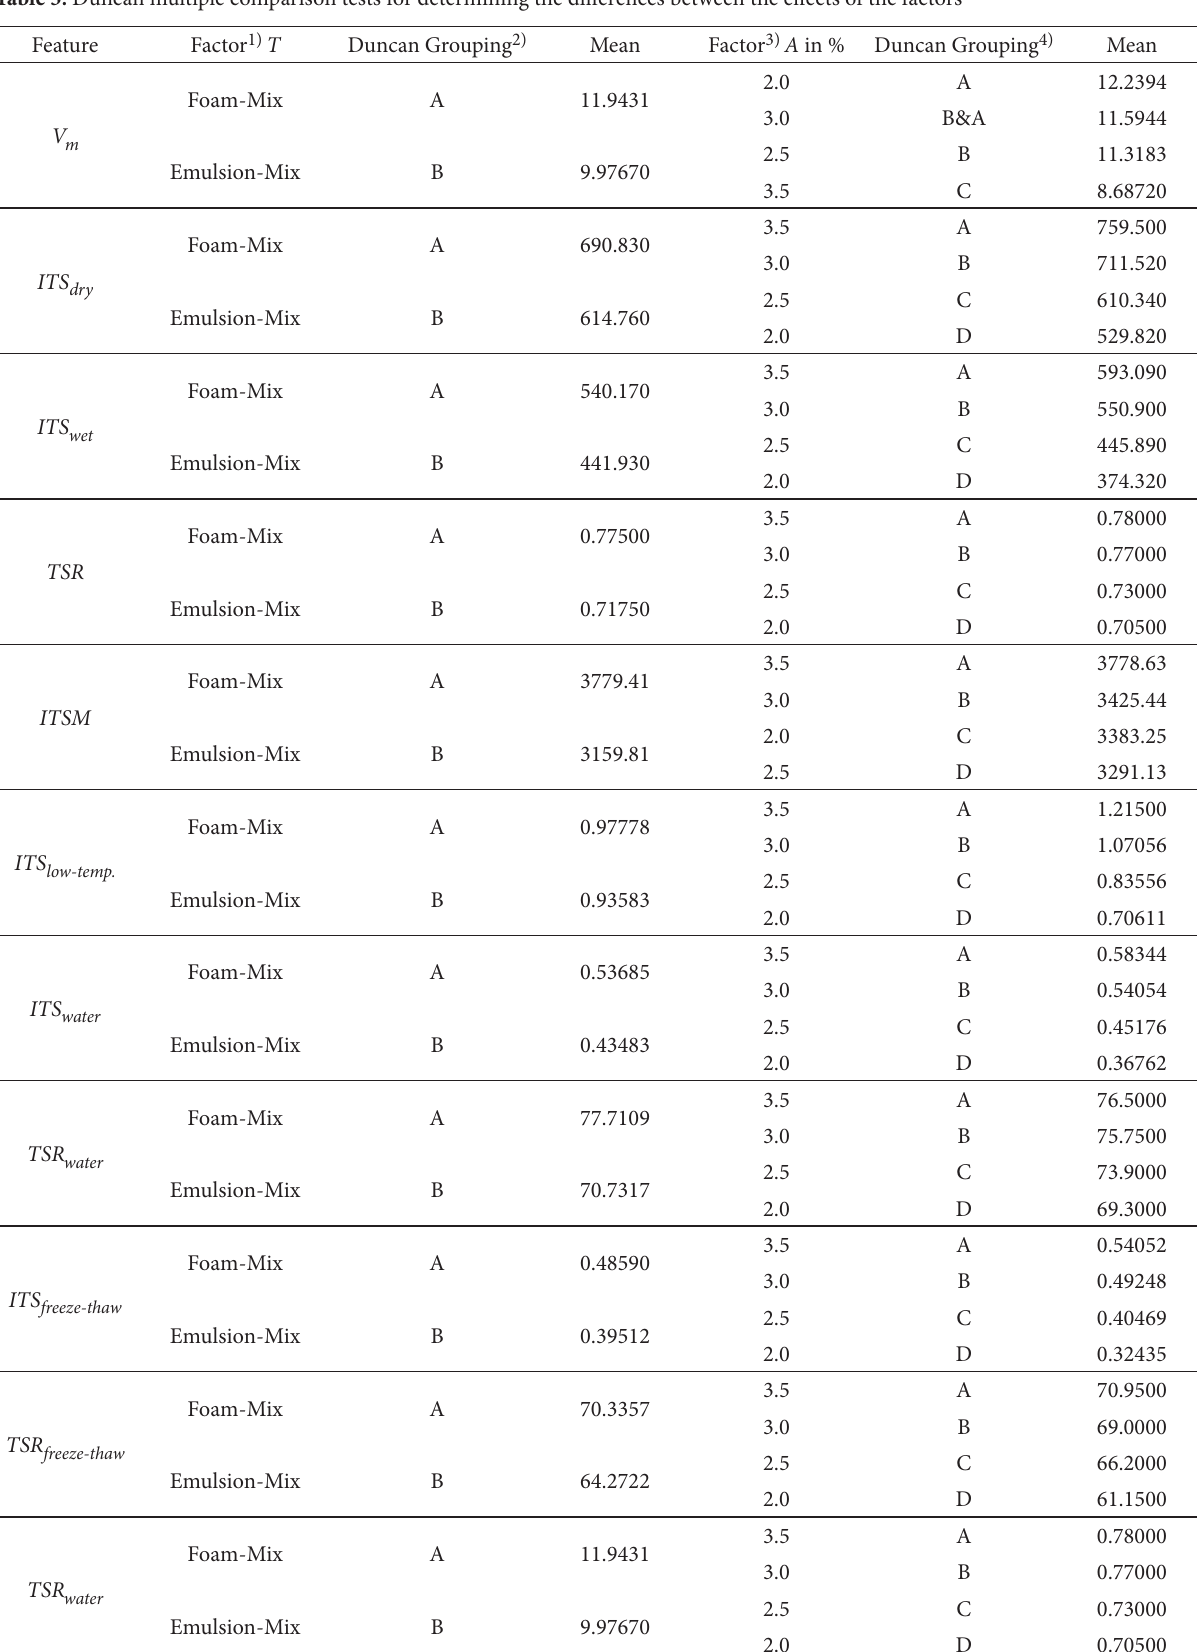
Table 5. Duncan multiple comparison tests for determining the differences between the effects of the factors